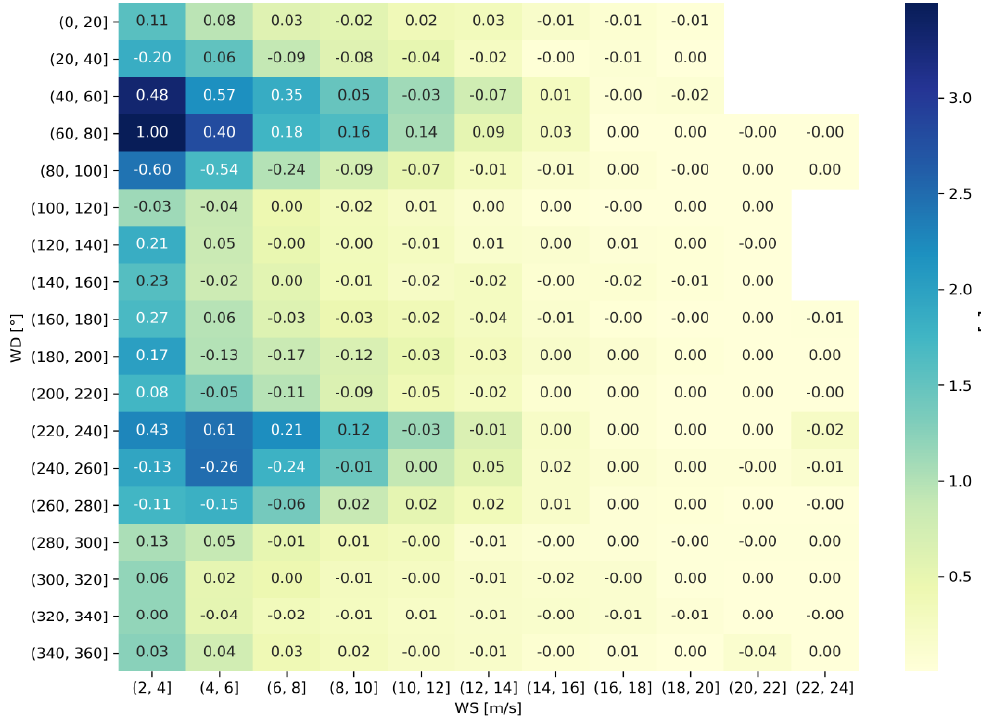
n (cid:16) (cid:17) (cid:80) = 1 − 1 = P SWM /P BLM and σ (cid:15) n i, N6N8 i, N6N8 p p i = 0